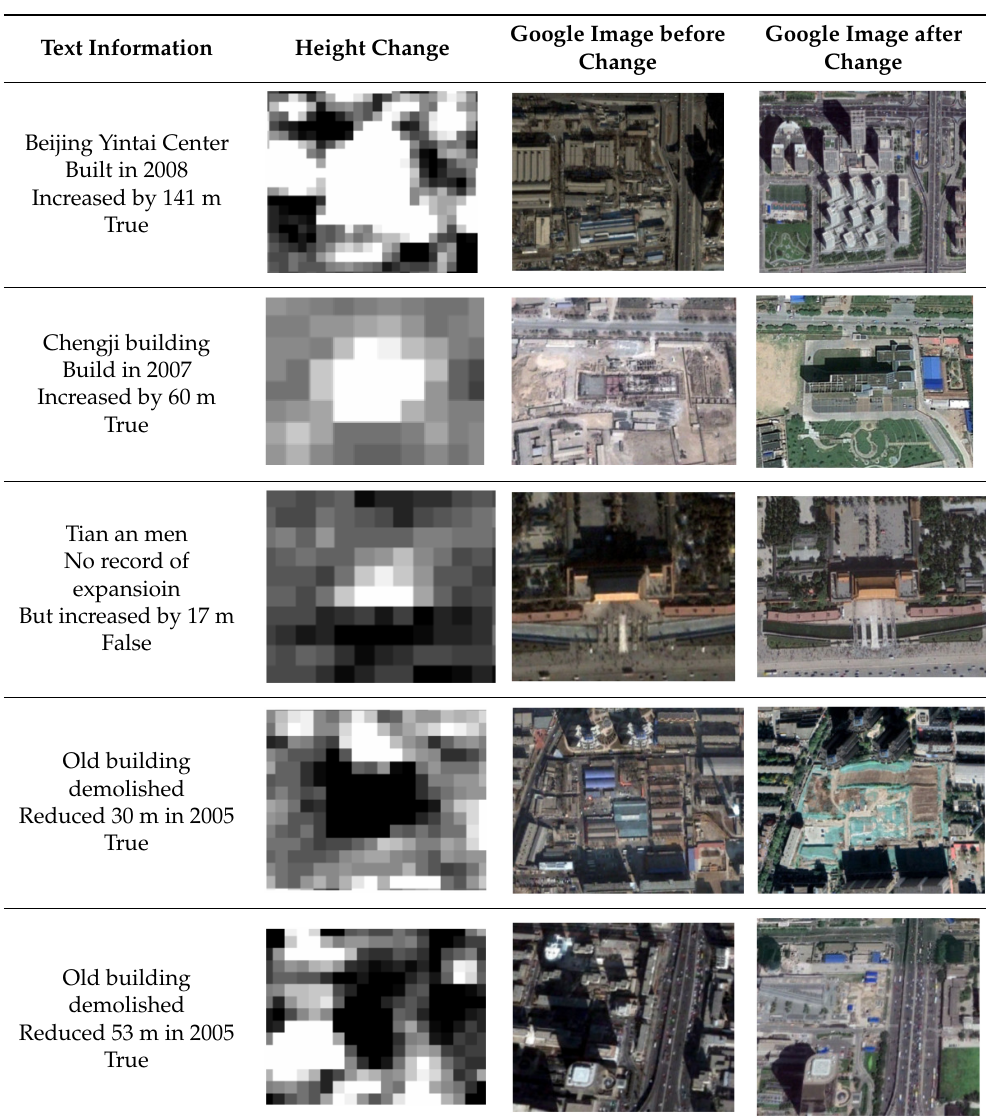
Table 3. Verification and evaluation of elevation change